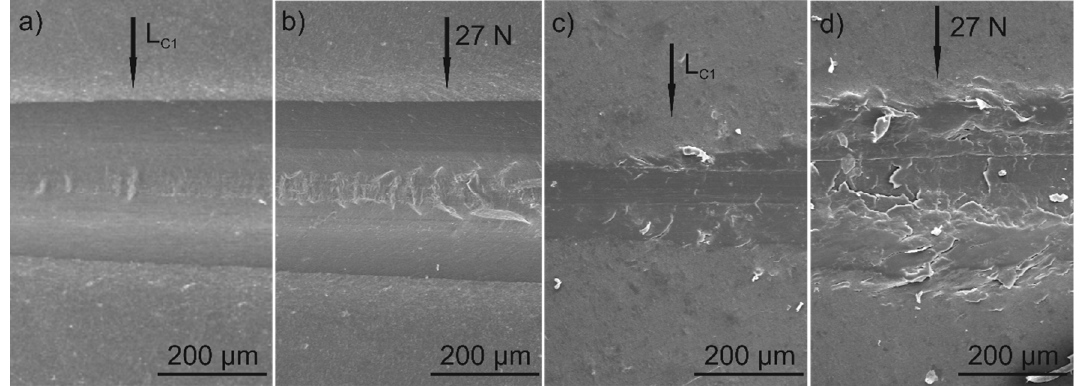
Figure 10. SEM images of the scratch track show the failure of PEEK coating at critical load L C1 = 23 N ( a ) and at 27 N ( b ) as well as graphite/PEEK coating at L C1 = 9 N ( c ) and at 27 N ( d ).